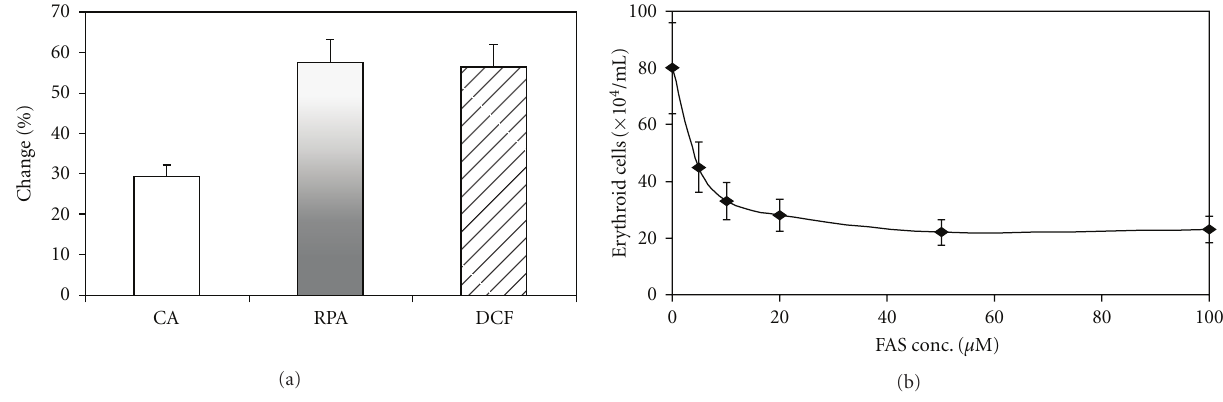
Figure 4: The e ff ects of non-transferrin iron uptake on cytoplasmic and mitochondrial LIP and ROS generation by cultured erythroid precursors. Cultured human erythroid precursors were harvested on day 6 of phase II, incubated with or without 20 μ M FAS for 1hr, and stained with CA, RPA or DCF for measurement of cytoplasmic and mitochondrial LIPs and ROS generation, respectively. The results are expressed as the percent (%) change (mean ± SD, N = 4) in the MFIs following incubation with and without Fe, calculated per the MFI − Fe. (b) The indicated concentrations of FAS were added to day 6 cultures. Hb-containing cells were counted by benzidine staining on day 9. The results are expressed as the (mean ± SD, N =